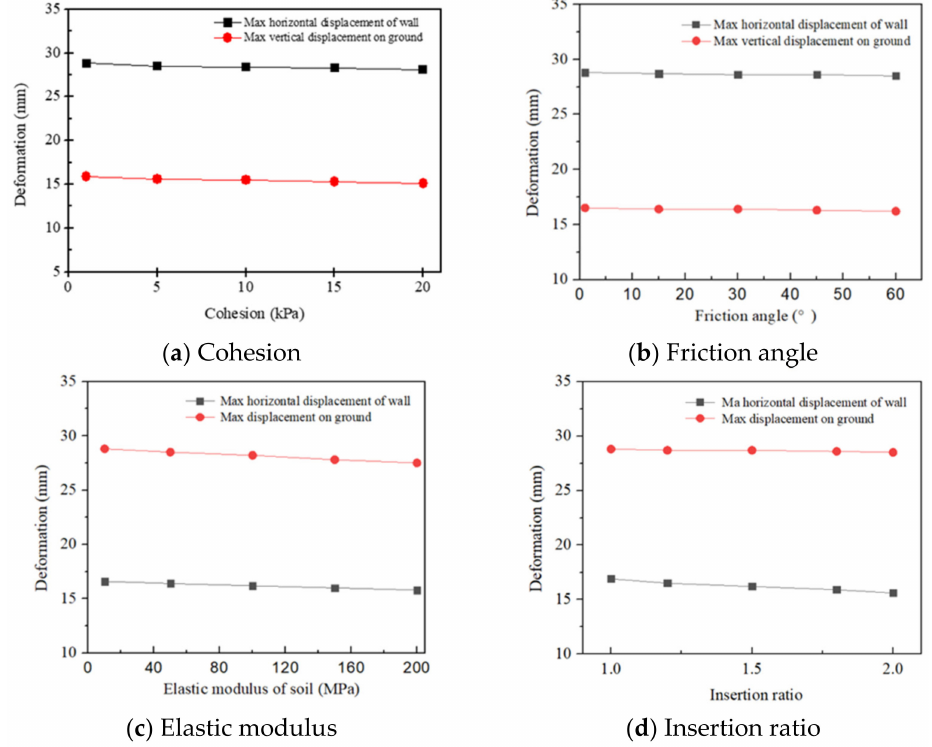
Figure 12. Displacement variation under different